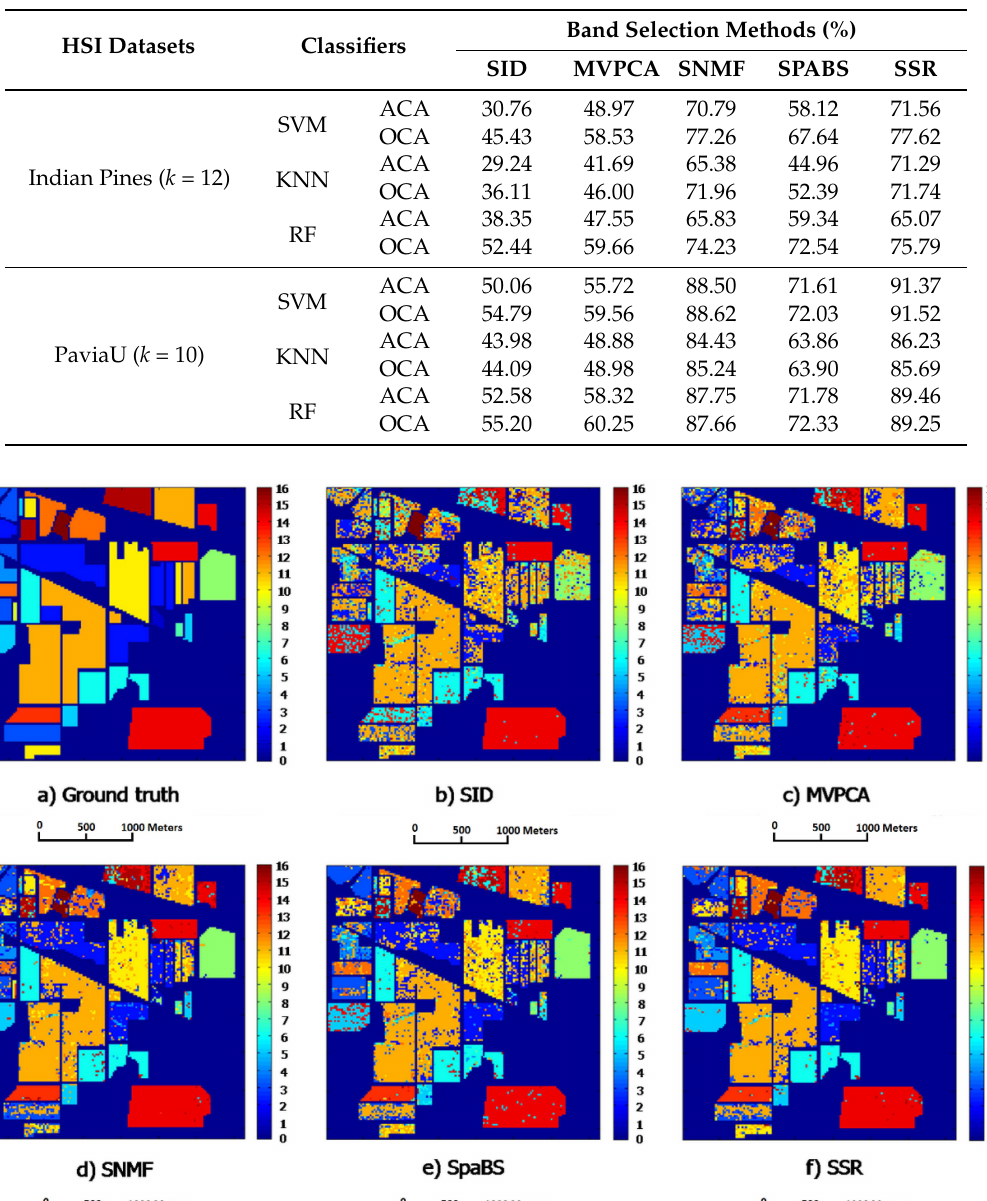
Table 4. Classification accuracies of all five methods with a certain k for both datasets.